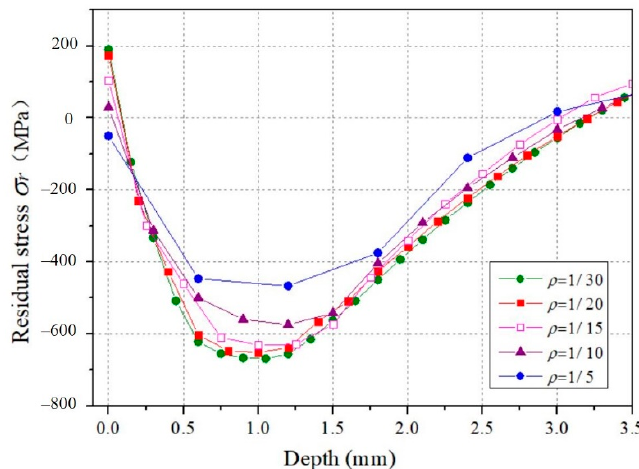
Figure 2. Effect of different values of ρ on residual stress σ r along the depth.